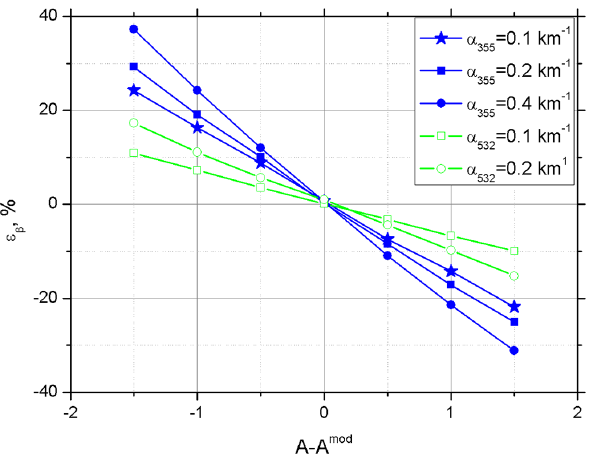
Figure 2. The uncertainty of backscattering coefficient calculation ε β at 355nm (blue) and 532nm (green) as a function of devia- tion from model value of Angstrom exponent A − A mod . Results are given for height z = 1000m and particle extinction coefficients = 1.03 and 0.1, 0.2, and 0.4km − 1 ; model values are A mod 355 − 387 = A mod 532 − 608